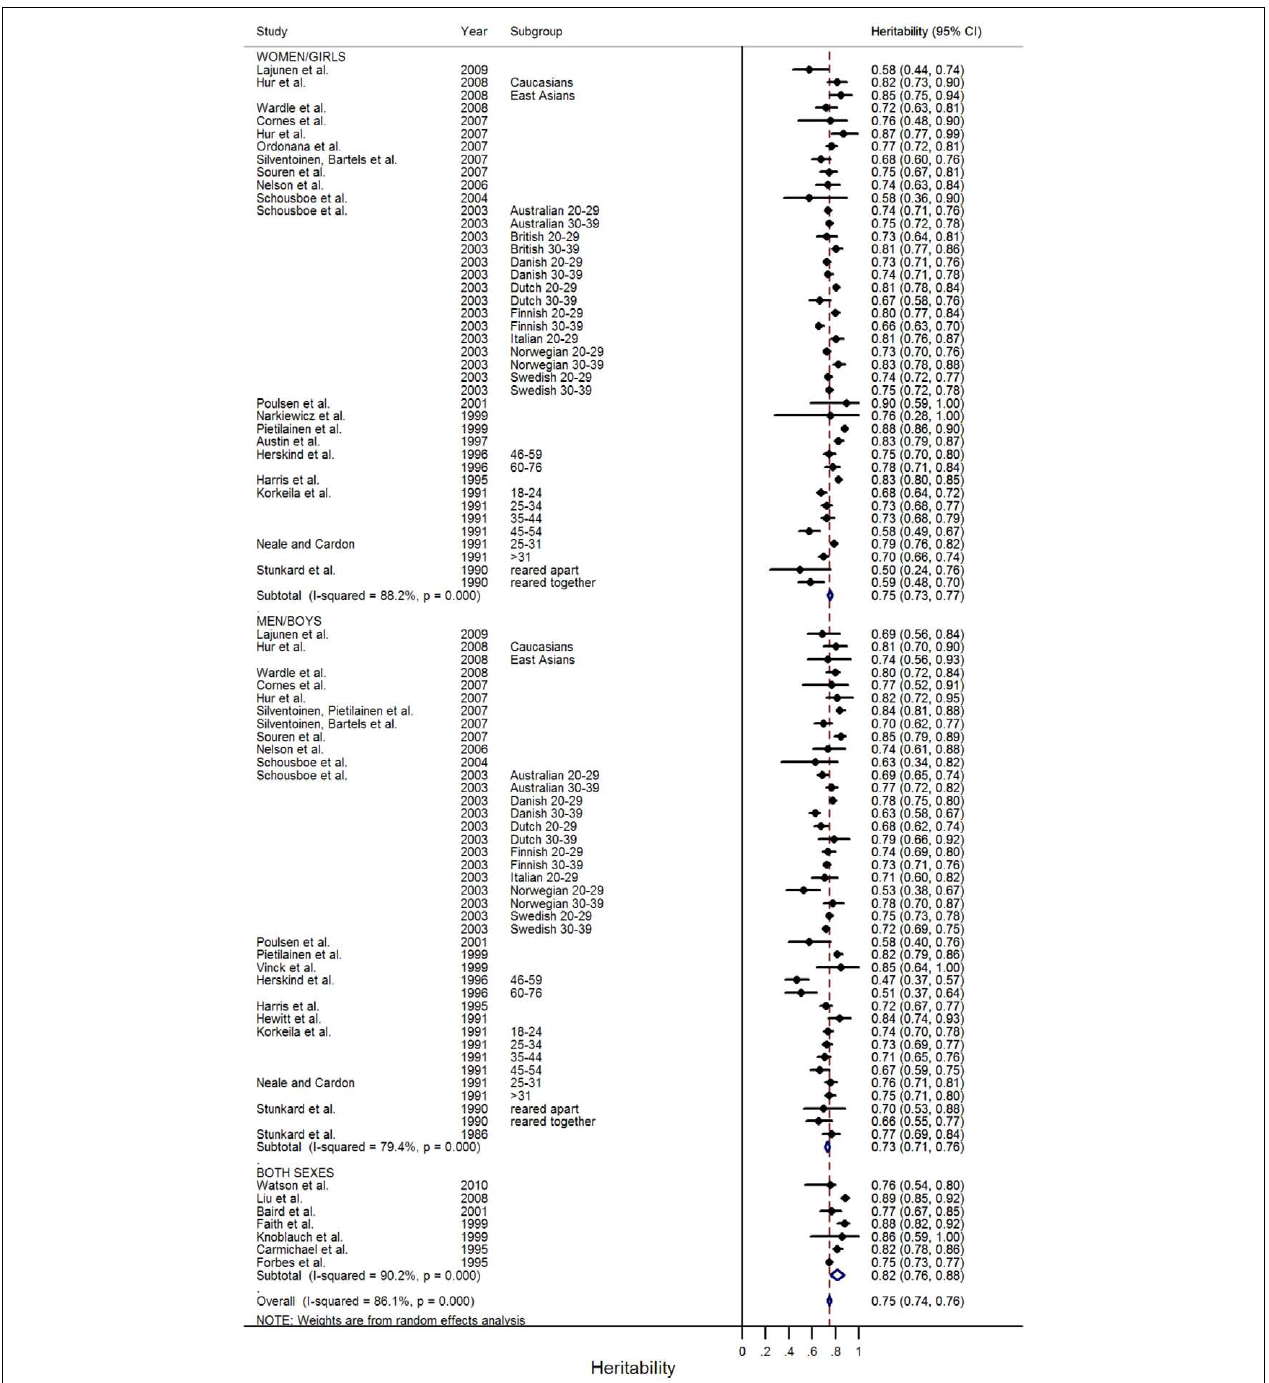
FIGURE 2 | Meta-analysis of BMI heritability estimates in twin studies. The forest plot shows the results of a random effects meta-analysis of 88 independent BMI heritability estimates from 31 papers.